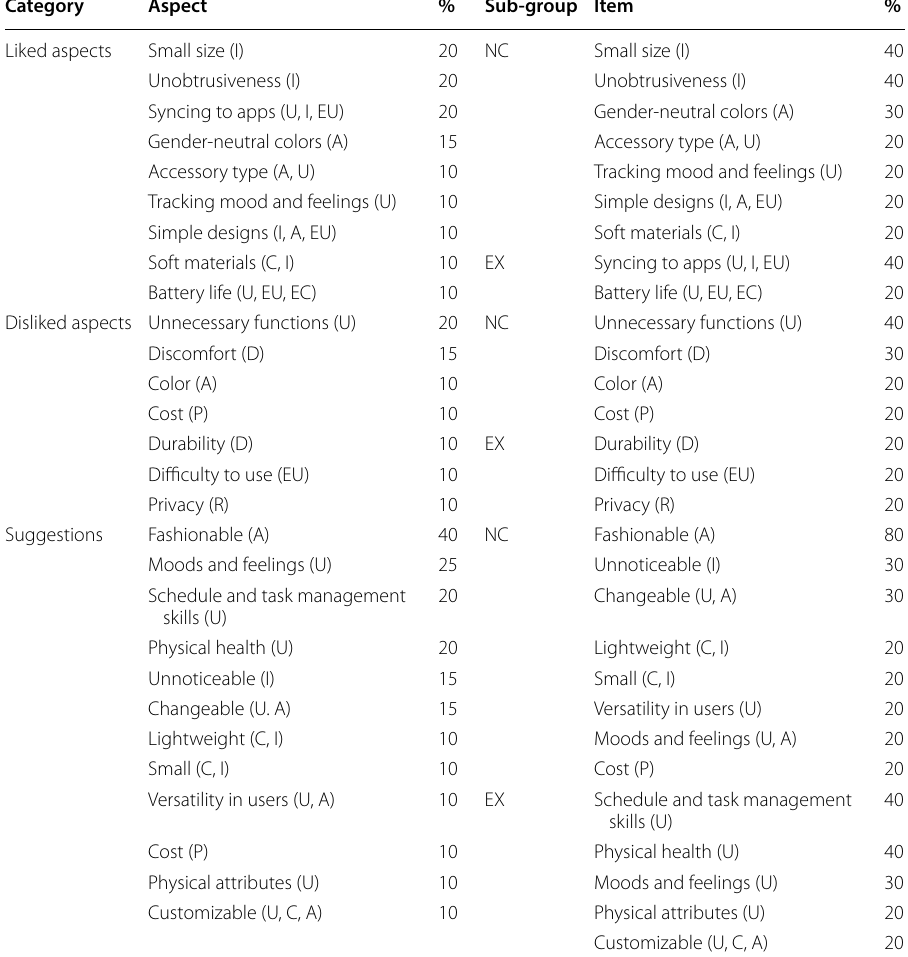
Table 2 Results for the research question